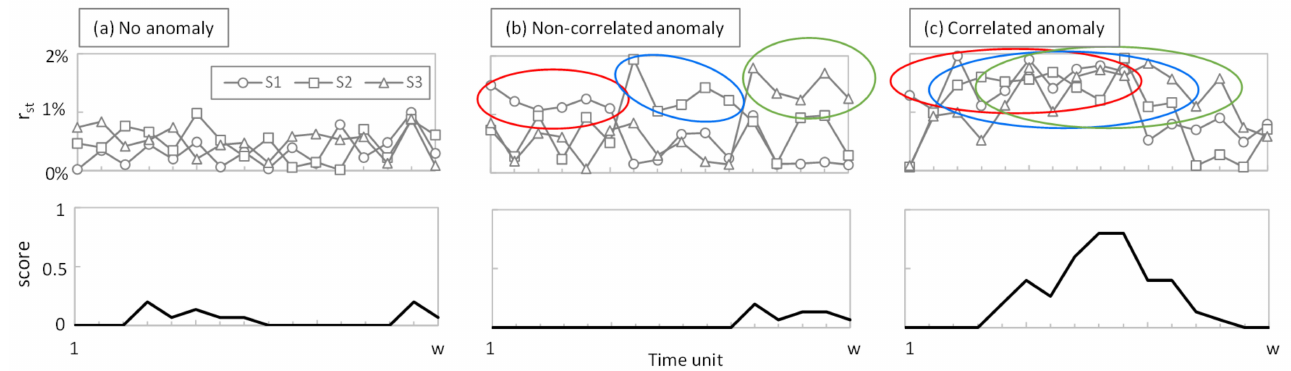
Figure 3. Example of the MS-AGD score: no ( a ), non-correlated ( b ), and correlated ( c )